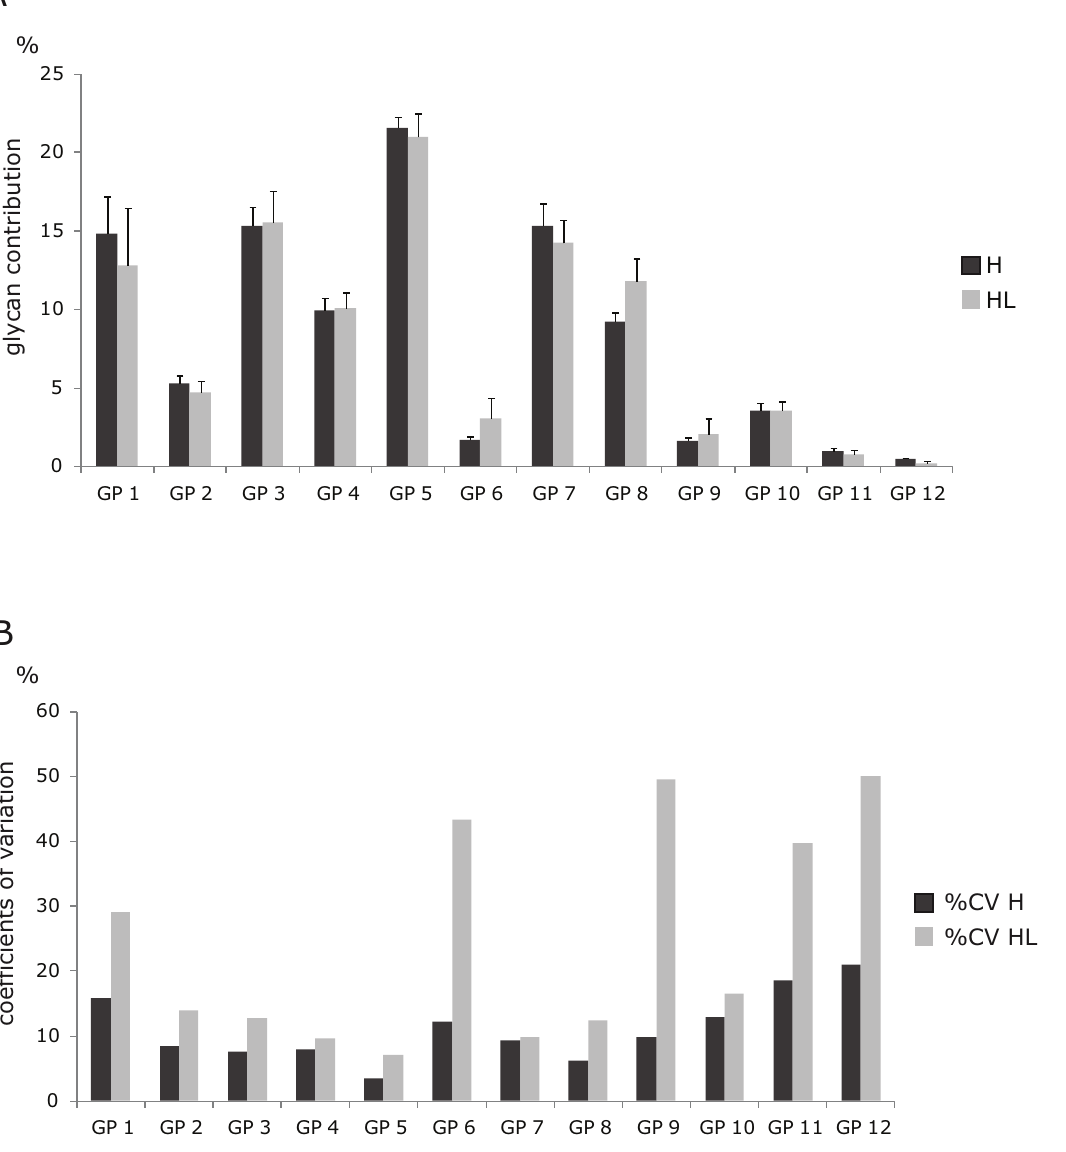
Figure 2. Composition of membrane and cell lysate N -glycomes. A. Glycans released from either HeLa cells embedded in polyacrylamide gels (H) or HeLa cell lysates (HL) were labeled with 2-AB and separated by HPLC. The histogram shows the partition (percentage + SD) of individual glycan fractions (GP1 – GP12) of HPLC separated glycome. B. Coefficients of variation (%CV) of individual glycan peaks in HPLC separated glycome of HeLa cells embedded in polyacrylamide gels (H) and HeLa cell lysates (HL) from 6 identical experiments.